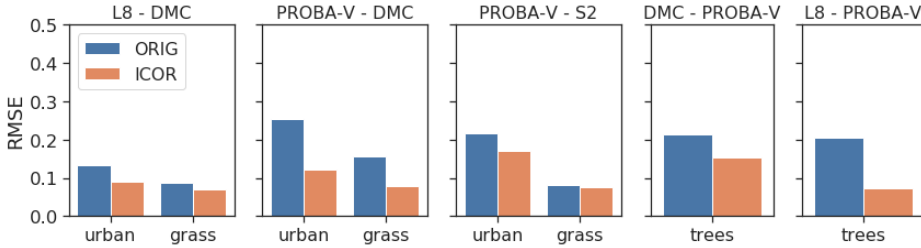
Figure 10. RMSE between match-up data from two sensors for the in situ sites. Colors indicate the corrections applied to the images.